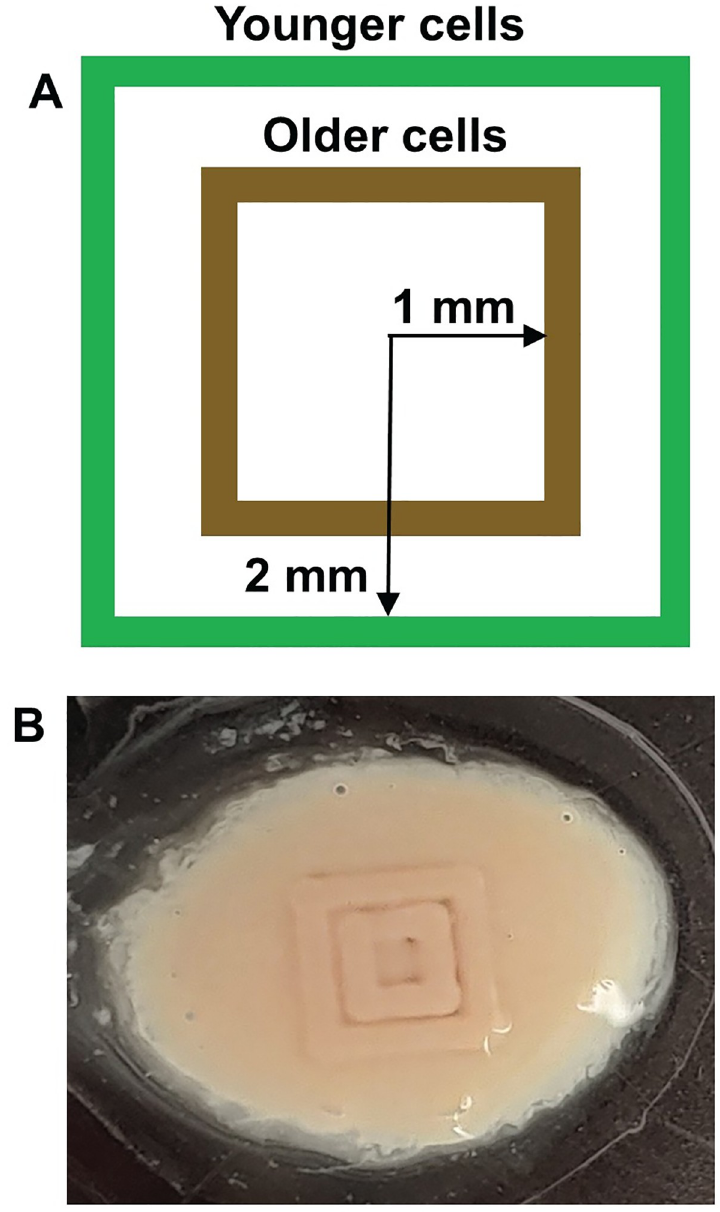
Fig 5. Laser ablation of biofilms in square perimeter patterns. A) Schematic of concentric ablation squares that are either 1 mm (older cell region, in brown) or 2 mm (younger cell region, in green) from the center of the biofilm, ablation of polycarbonate membrane biofilms. B) Optical image of post-ablation marks on polycarbonate biofilm. LAST combined with LC-MS/MS revealed proteins with statistically significant different abundances between anxoic and oxic regions of these transwell biofilms. The volcano plot in Fig 6 includes 250 proteins identified that satisfied the stringency conditions of at least two peptides and � 10% sequence coverage, out of a total of 430 proteins identified. An oxygen- selective electrode distinguished the oxic from anoxic regions in biofilms of this same strain grown in the same medium and cultivation system (albeit for a shorter growth period) [8], but